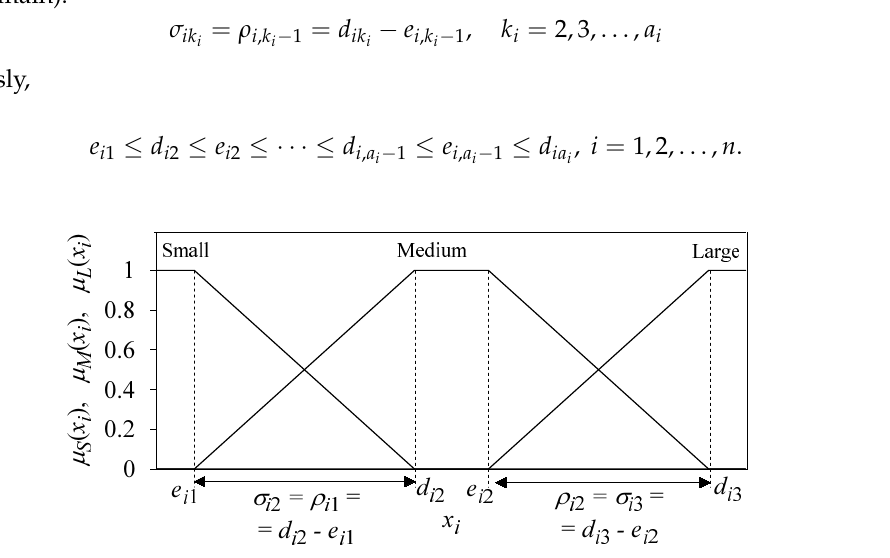
Figure 3. Illustration of the strong fuzzy partition (SFP) requirements for the three-set SFP of x i